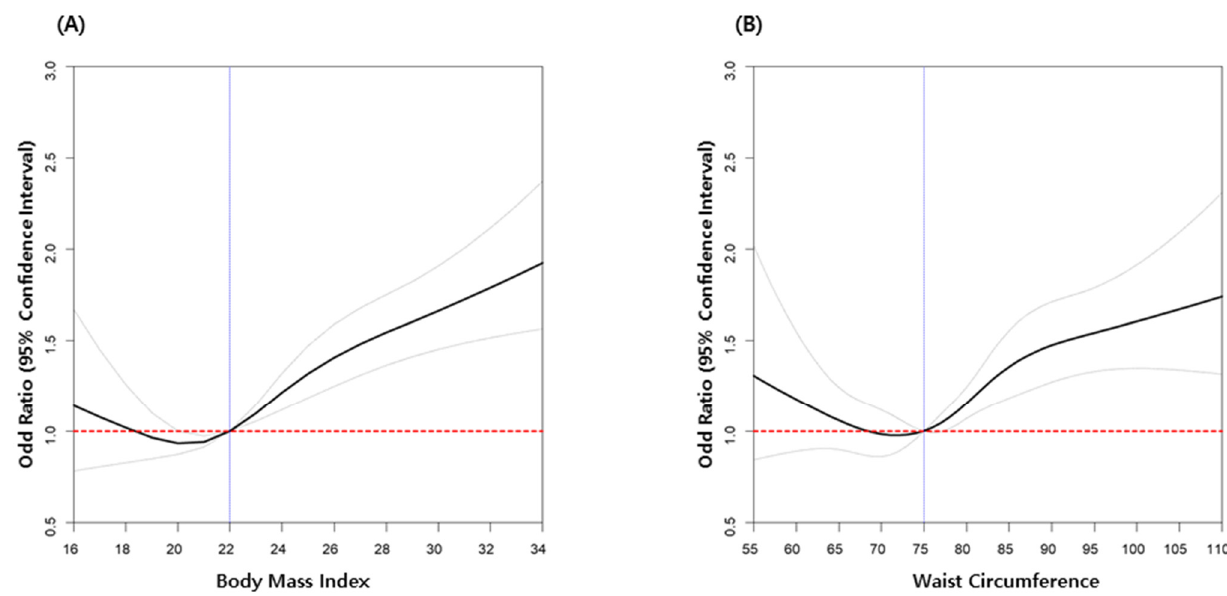
Abbreviations. CKD, chronic kidney disease; HR, hazard ratio. Model 1: non-adjusted. Model 2: adjusted for age, sex. Model 3: adjusted for model 2 plus smoking, alcohol drinking, regular exercise, income. Model 3: adjusted for model 3